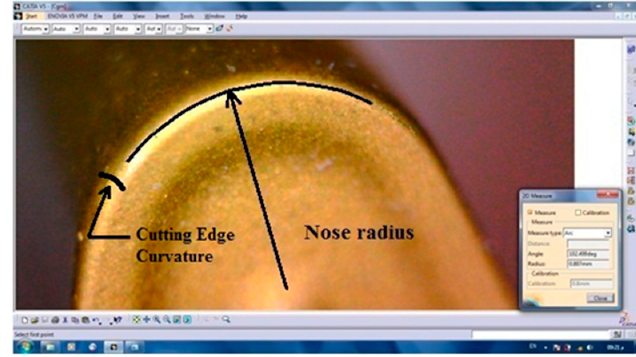
Figure 5. Machine setup.